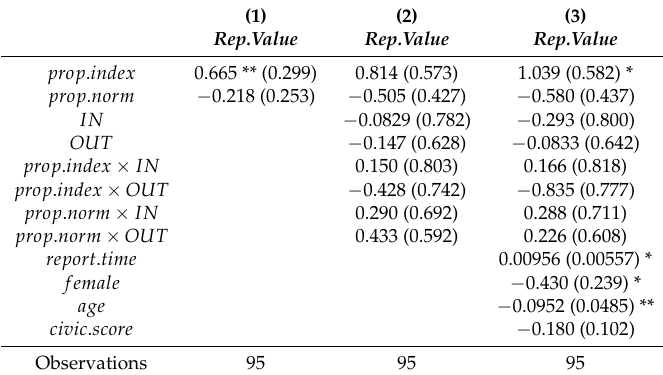
Table A1. Dictators’ self-reported values (ordered probit